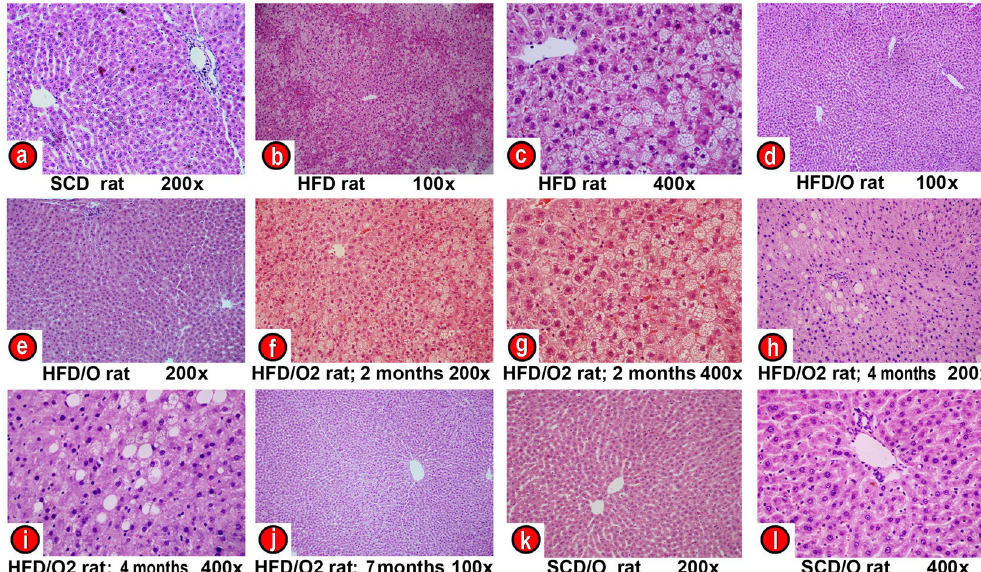
Figure 3. Effects of omentectomy on the liver histology. ( a ) Control rat on a standard chow diet (SCD-rat). ( b,c ) Rat on a high-fat diet for 7 months (HFD-rat). ( d,e ) Rat on a HFD undergoing omentectomy at the age of 6 weeks (HFD/O-rat). ( f,g ) Rat on a HFD for two months (HFD/O2-rat) showing severe hepatic steatosis, mainly microvesicular. After biopsy, omentectomy was carried out in the same rat. ( h,i ) The liver of the same rat on a HFD for four months, two months after omentectomy, showing mild steatosis, mainly macrovacuolar. ( j ) The liver of the same rat on a HFD for 7 months, five months after omentectomy, showing normal liver histology. ( k,l ) Rat on a SCD that underwent omentectomy at the age of 6 weeks. Liver samples were stained with hematoxylin-eosin. Magnification 100x ( b,d,j ), 200x ( a,e,f,h,k ), 400x ( c,g,i,l